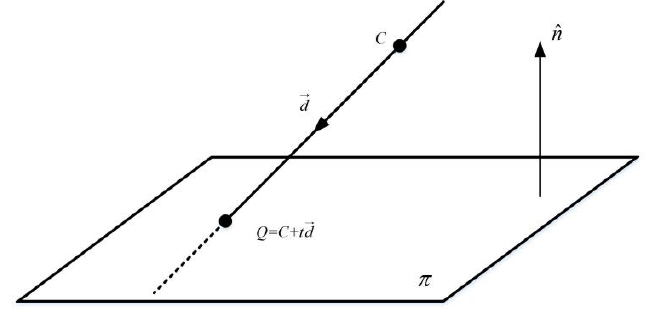
Figure 3. Intersection between a straight line and a plane.